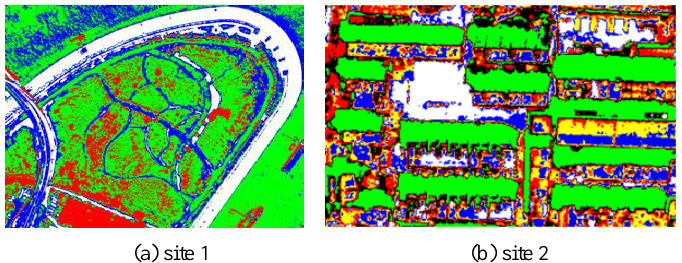
Figure 6. Results of FCM clustering segmentation only employing spectral features